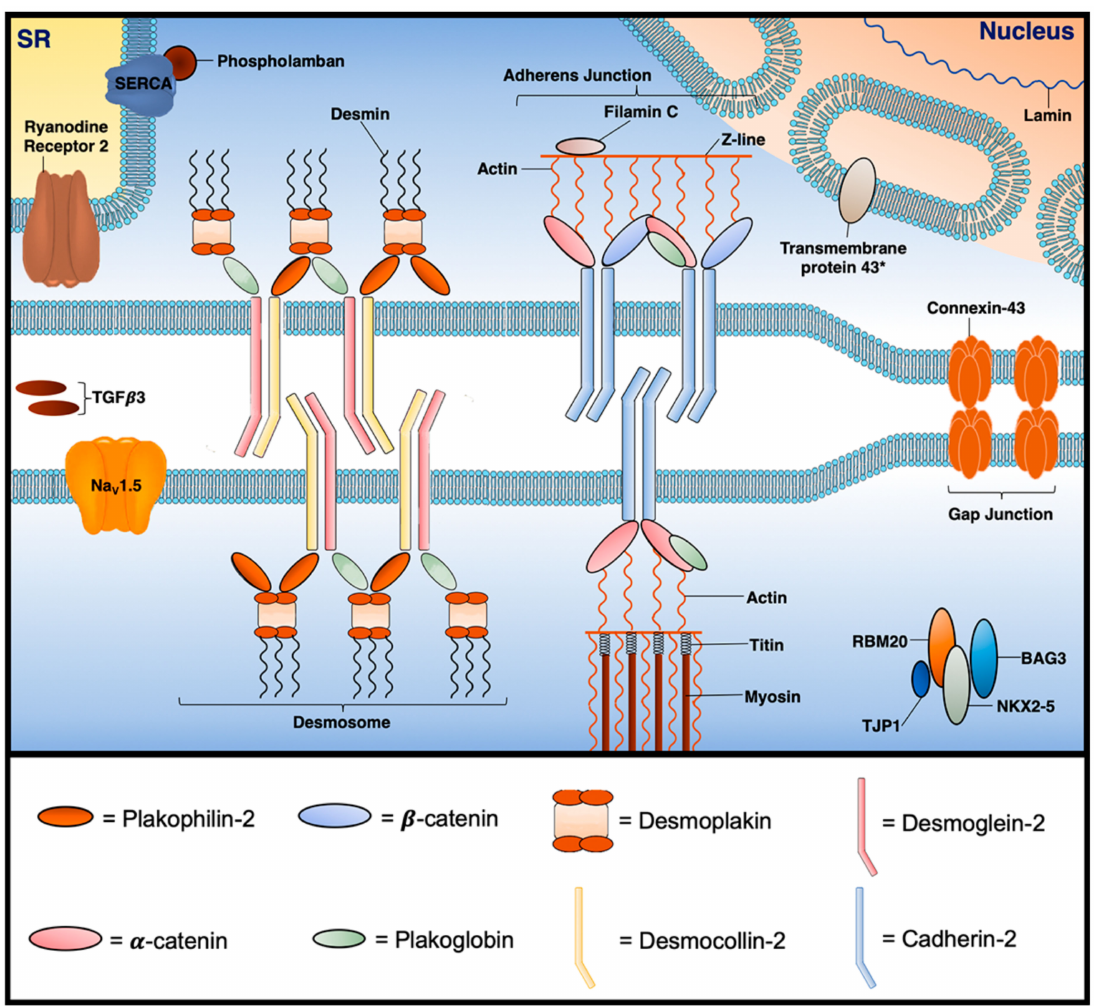
Figure 20. Select proteins implicated in the pathogenesis of ACM at the cardiomyocyte junction. BAG3 = BAG family molecular chaperone regulator 3; Na v 1.5 = voltage-gated Na + channel 1.5; NKX2-5 = NK2 homeobox 5; RBM20 = RNA-binding motif protein 20; SERCA = sarcoplasmic reticulum Ca 2 + ATPase; SR = sarcoplasmic reticulum; TGF- β 3 = transforming growth factor β 3; TJP1 = tight junction protein. * = location is still